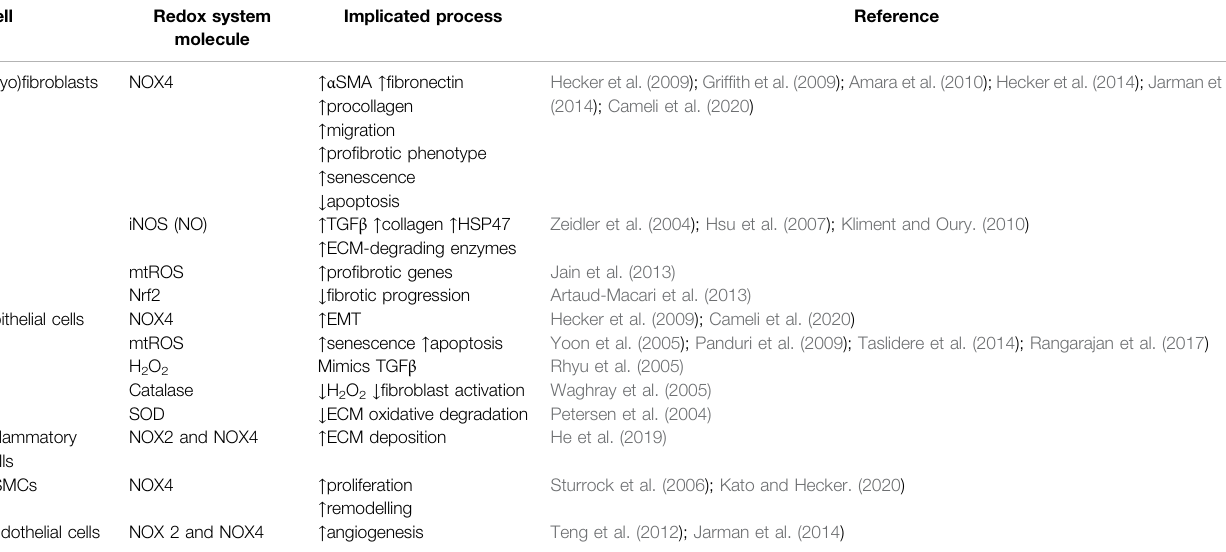
TABLE 1 | Summary of the molecules of the redox system and the implicated process in the IPF participating cells.